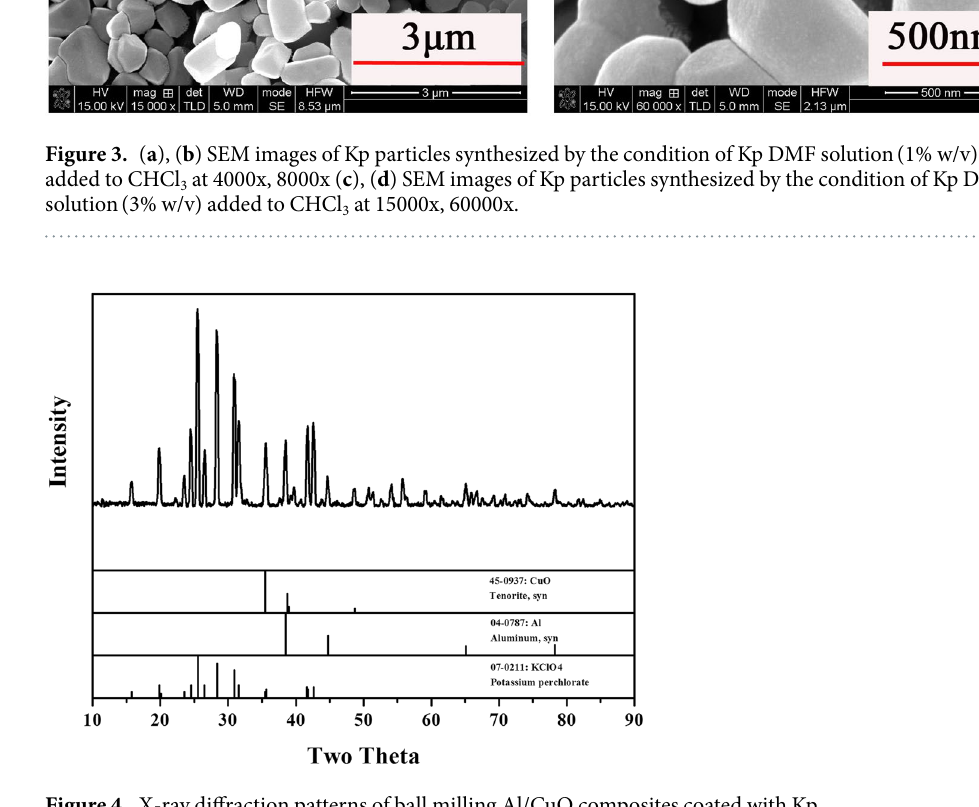
Figure 4. X-ray diffraction patterns of ball milling Al/CuO composites coated with